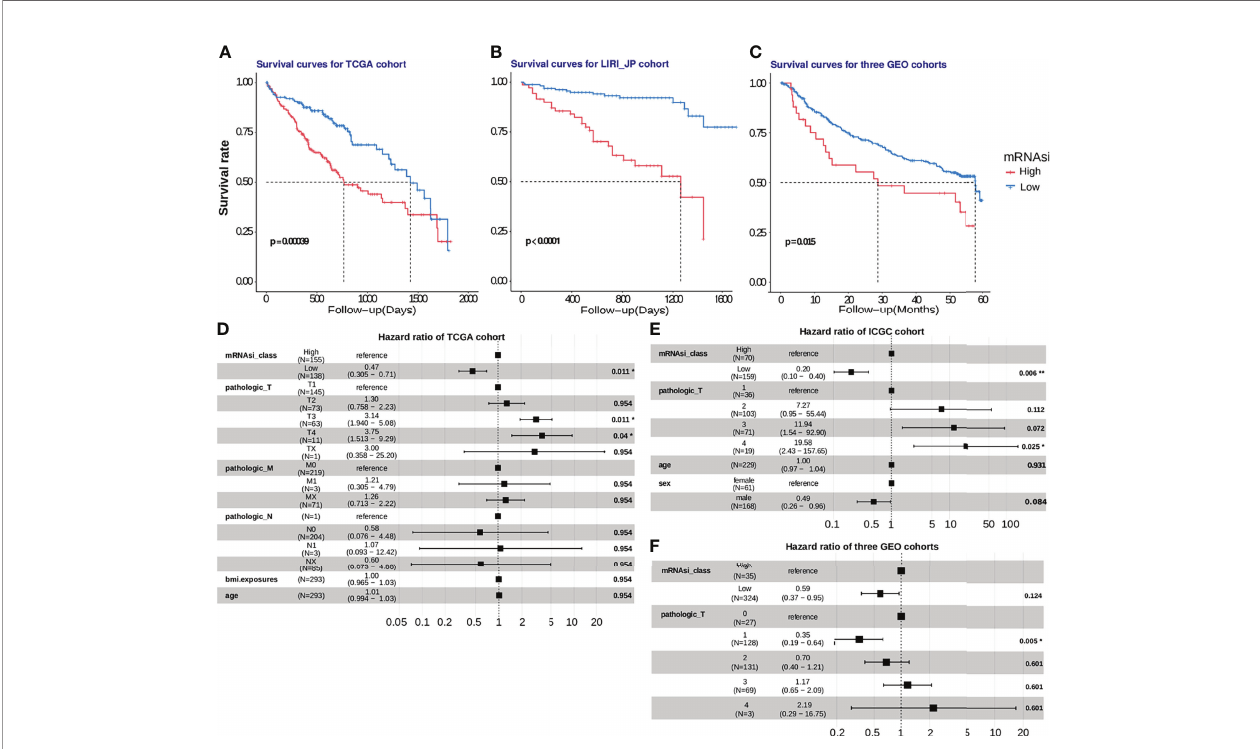
FIGURE 7 | Development and validation of the mRNAsi cutoff value in fi ve HCC cohorts. (A) In the TCGA-HCC cohort, patients with high stemlike indices (mRNAsi > 0.55) suffered from worse survival outcomes, compared to those in the low-mRNAsi group with log-rank test P =0.00039. (B, C) The mRNAsi cutoff value was further veri fi ed using the ICGC-JP cohort and 3 GEO cohorts, and the mRNAsi-based cutoff was a signi fi cant hazard factor for HCC patients with log-rank test p<0.0001 and p = 0.016. (D, E, F) . The hazard ratios of mRNAsi were shown using a forest plot in the training and validation